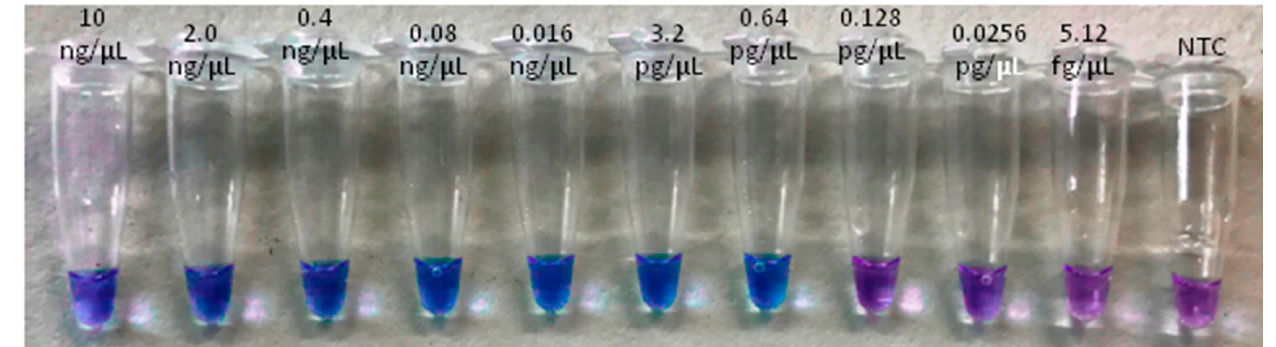
Plants 2021 , 10 , x FOR PEER REVIEW 7 of 16